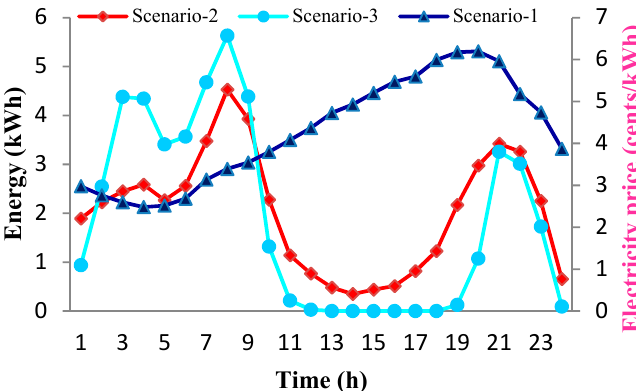
Figure 9. Energy consumption and electricity cost management for three scenarios over 24 h time horizon. Some effective strategies and RESs integration are taken in to account in the proposed scheme.